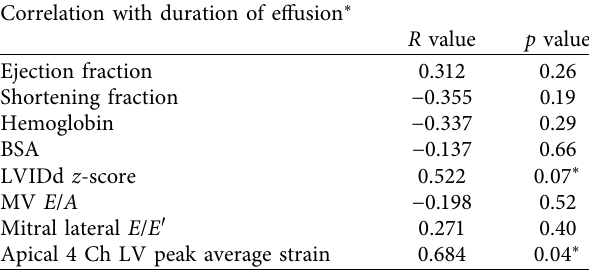
Table 4: Correlation between duration of pericardial efusion and pretransplant cardiac